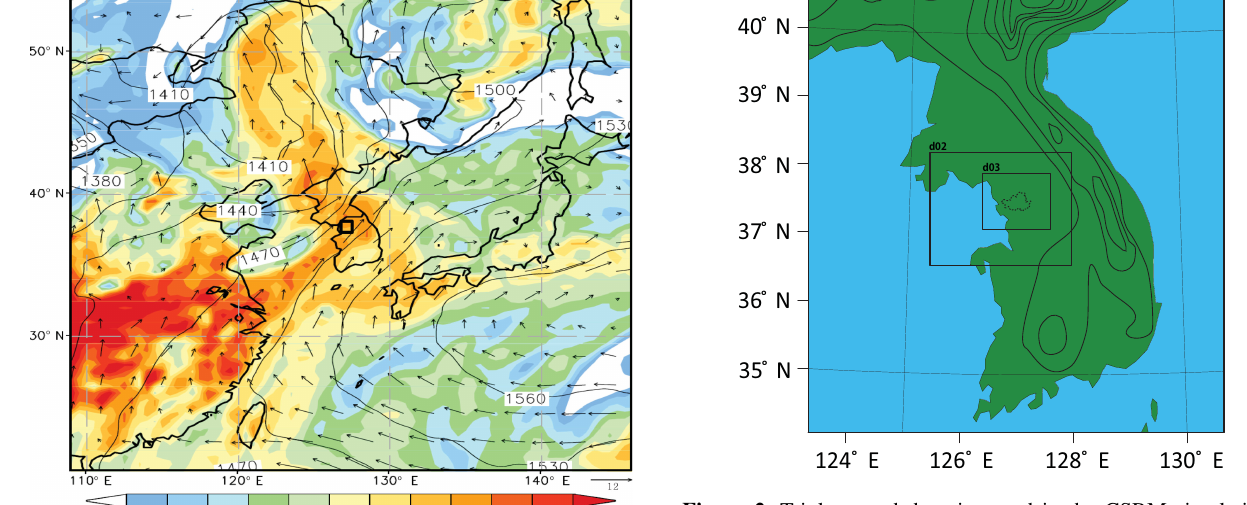
Figure 2. Triple-nested domains used in the CSRM simulations. The boundary of the figure itself is that of Domain 1, while the rectangles marked by “d02” and “d03” represent the boundary of Domain 2 and Domain 3, respectively. The dotted line represents the boundary of Seoul and terrain heights are contoured every